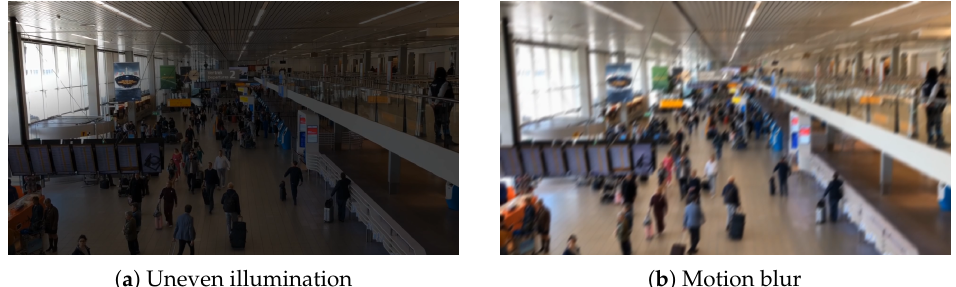
Figure 1. Examples of quality degradations in SIs: ( a ) the SI suffers from uneven illumination distortion; ( b ) the SI suffers from motion blur